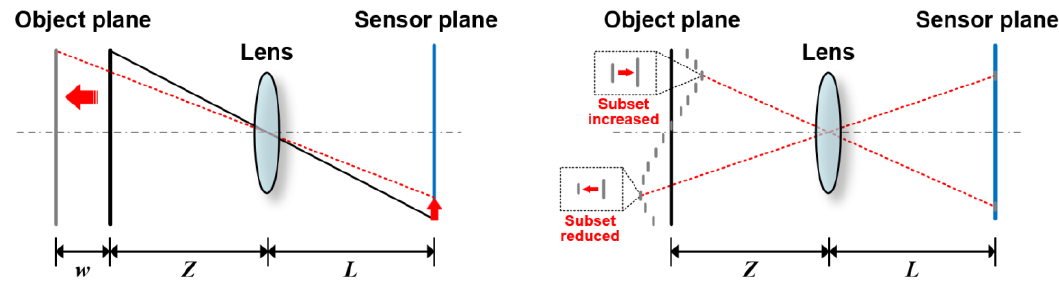
Figure 2. Schematic of the virtual in-plane displacement induced by the specimen’s out-of-plane motion.